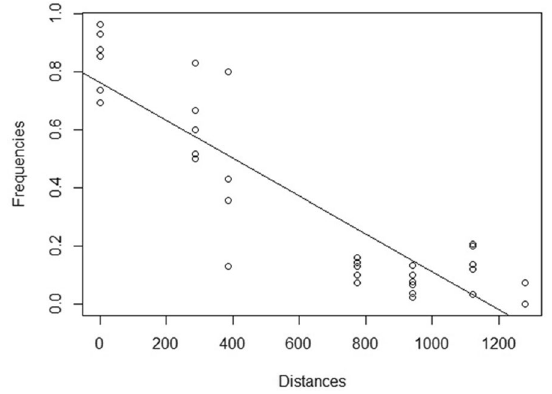
Figure 2. Linear regression model between the frequency of ATL haplogroup and geographic distance considering all years of the research. The model showed a significant decrease in ATL frequency when the geographic distance